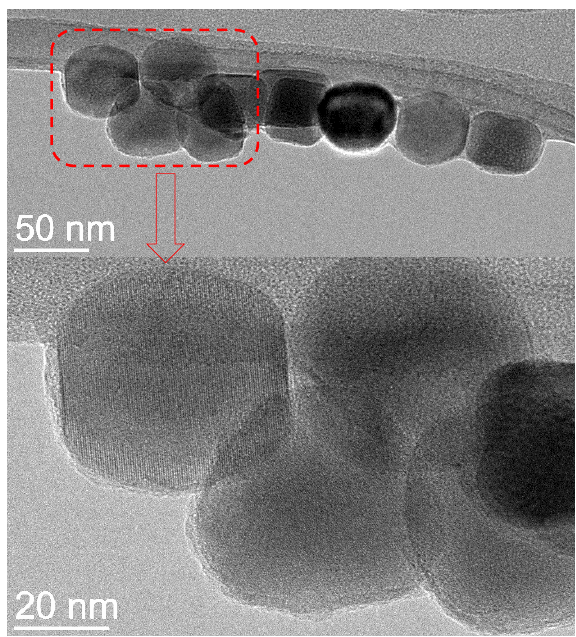
Figure S3. TEM images of the UCNPs@PB- 105 from 1-month old dispersions in PBS. The image at the bottom presents an enlarged section from the top